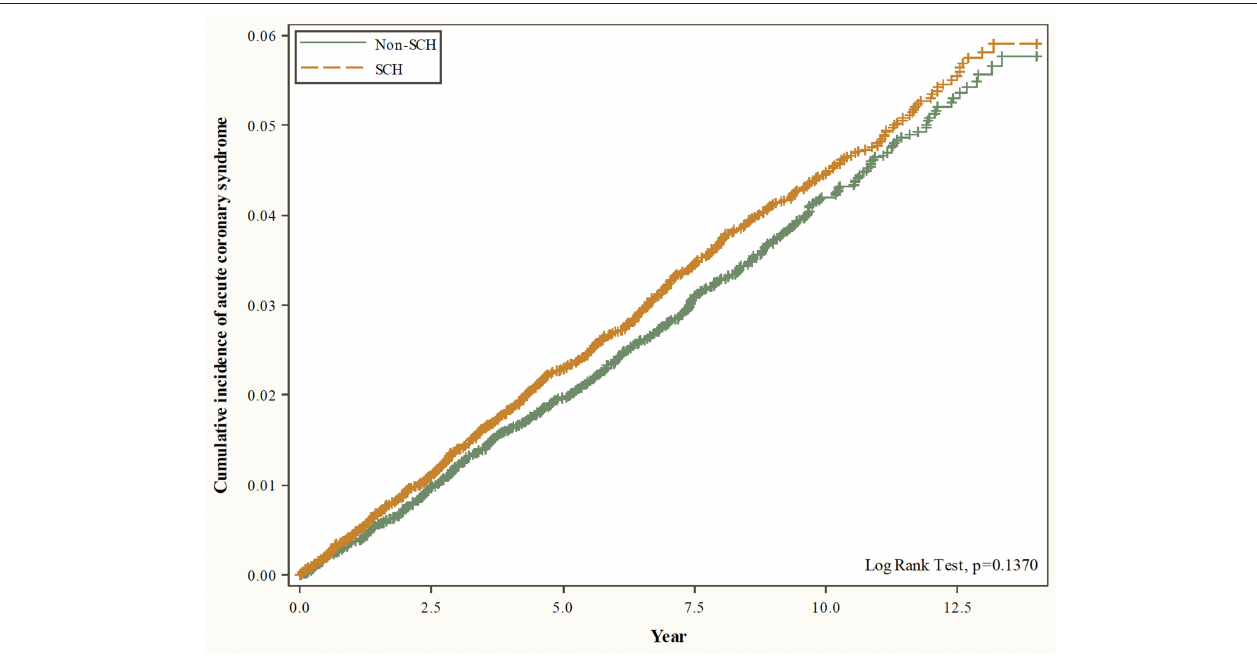
FIGURE 2 | Cumulative incidence of acute coronary syndrome in patients with and without SCH using the Kaplan-Meier